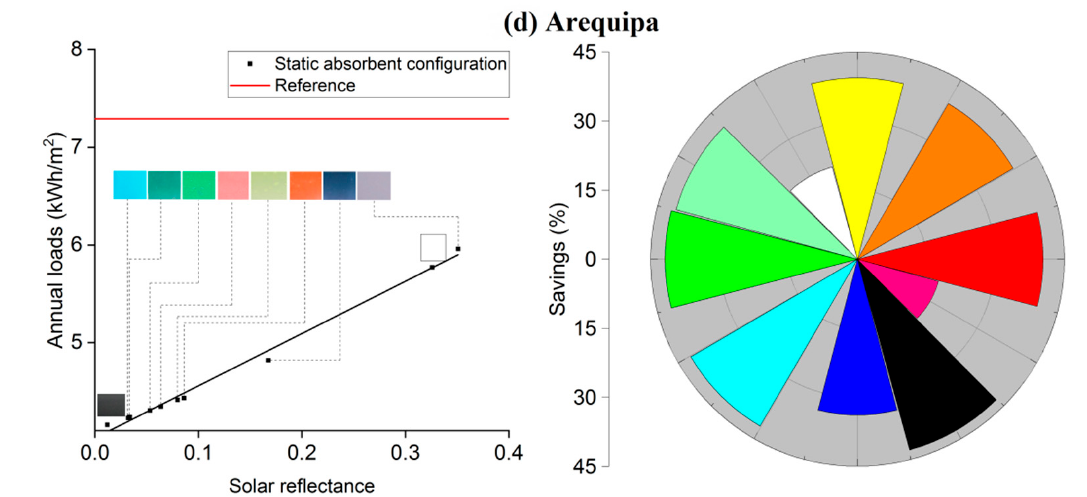
Figure 5. HVAC load savings in climate B (Arid): ( a ) Tenerife, ( b ) Lerida, ( c ) Las Vegas, ( d ) Arequipa. Right graphs: static con fi guration, solid color, dynamic con fi guration, striped color.